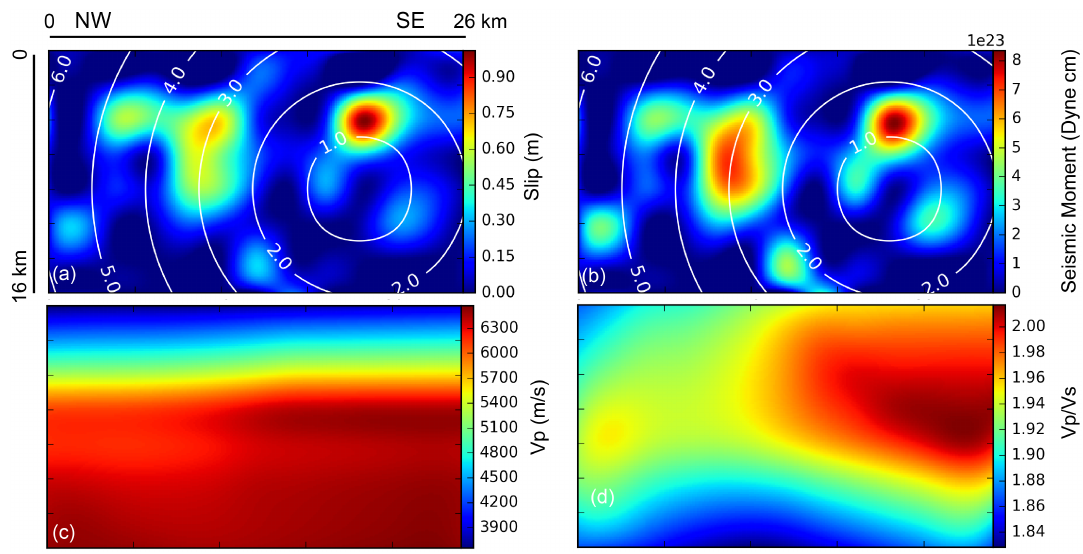
Figure 1: a) Slip model imaged in [Tinti et al.(2016)], Slip amplitudes are expressed in meters and rupture times (white contouring) in seconds. The inferred rupture velocity is 3100 m/s. b) Rupture model used in this paper, described as seismic moment release, considering the material properties on the fault plane. c) and d) are the imaging of Vp and Vp/Vs on the fault plane, derived from Di [Di Stefano & Ciaccio.(2014)]. The transition zone between the slower NW part and the faster SE part corresponds to the Olevano-Antrodoco